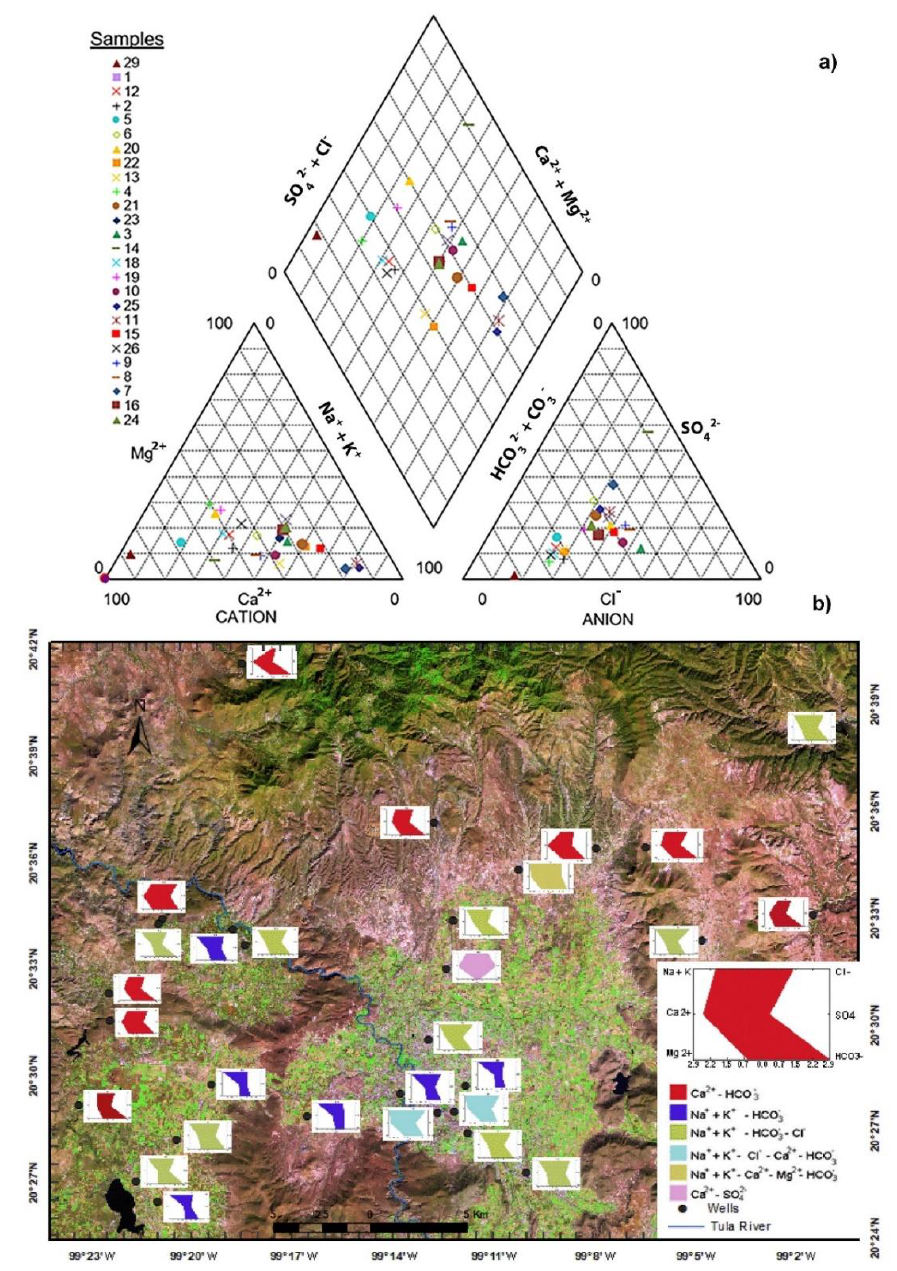
Figure 2. Piper and Stiff diagrams. ( a ) Piper diagram showing the water types according to geochemical differences; ( b ) Stiff diagrams projected spatially, showing the water types in the study zone.